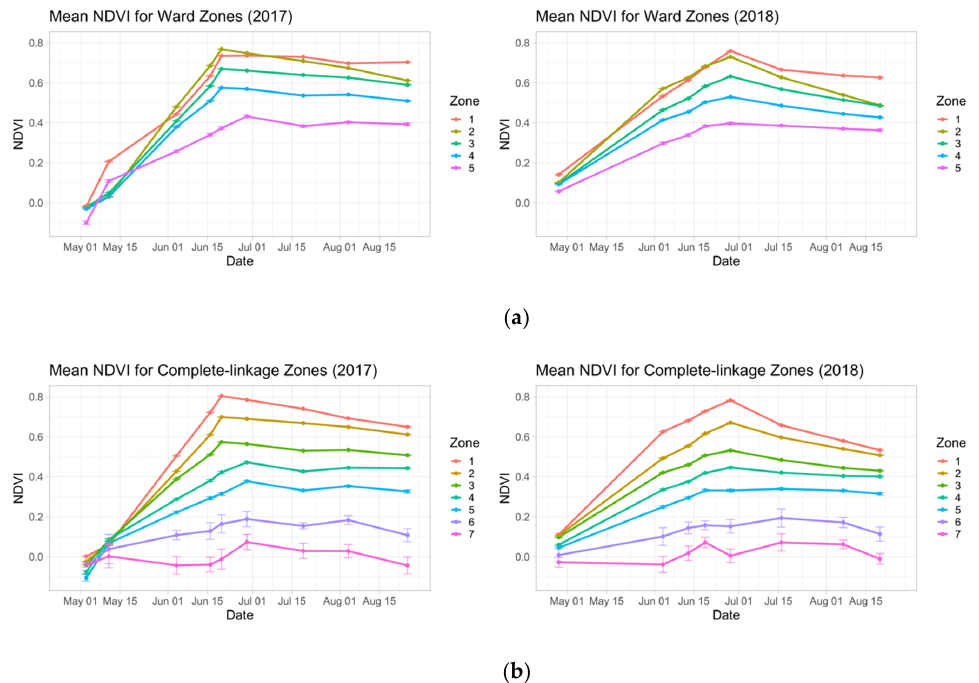
Figure 8. Temporal dynamics within each zone established by the ( a ) Ward method and ( b ) complete linkage method through clustering NDVI time series from satellite imagery. Error bars show the 99% confidence interval for the mean. Some error bars for very narrow confidence intervals appear as horizontal lines.